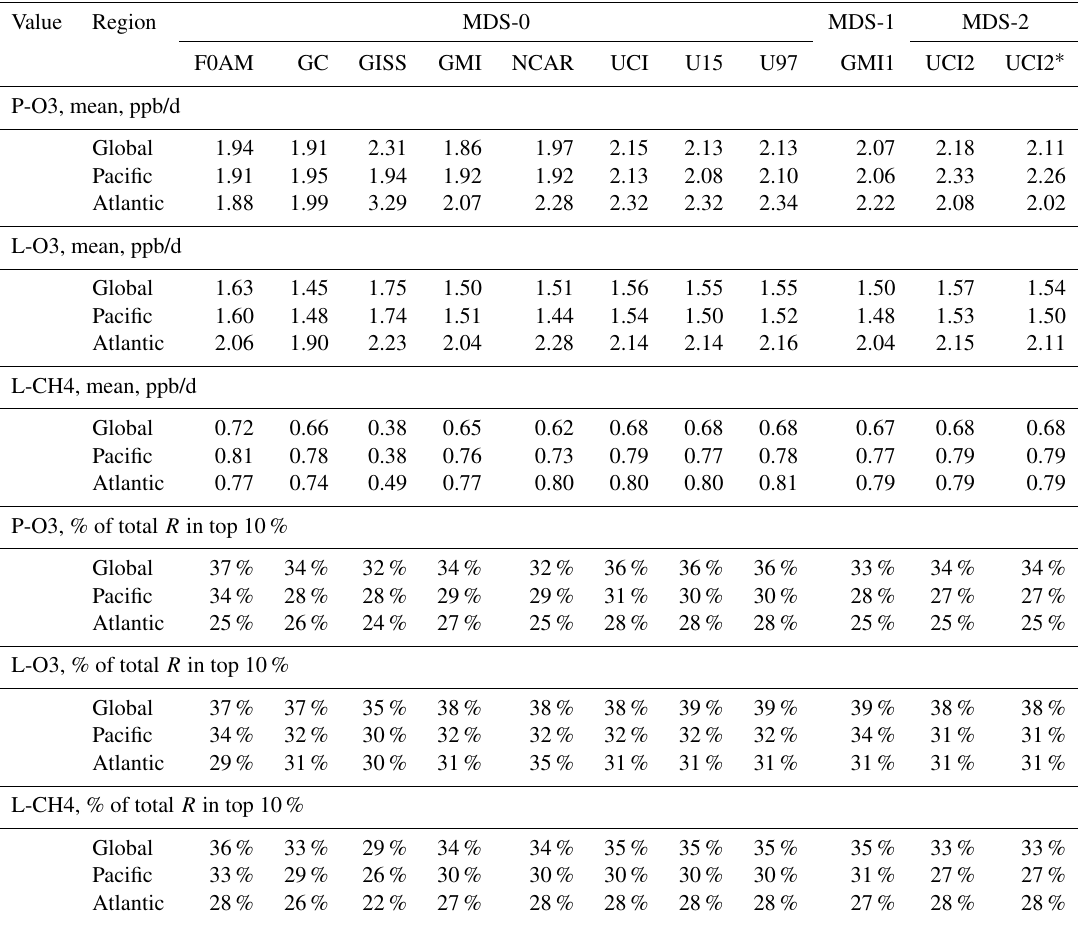
Table 2. Reactivity statistics for the three large domains (global, Pacific,